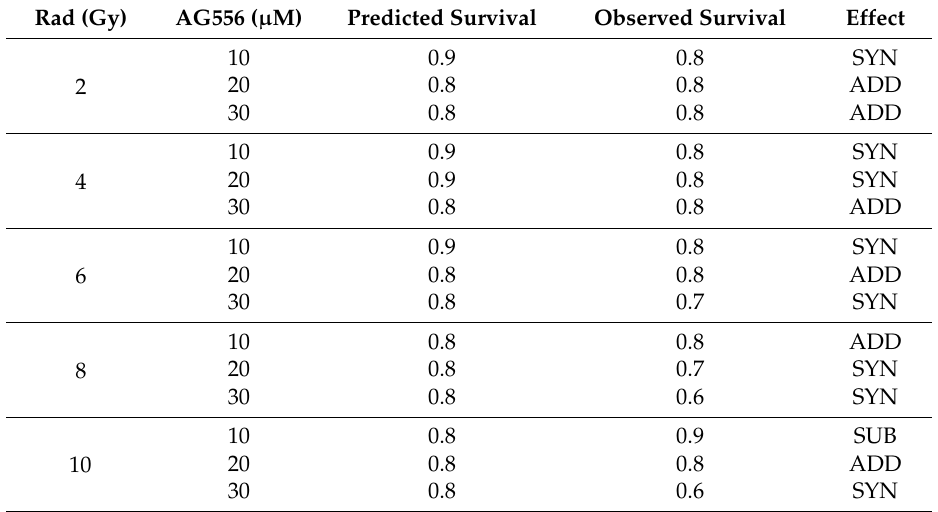
Table 1. The interaction between combined treatment in 11 HGG cells, three days after the treatment.